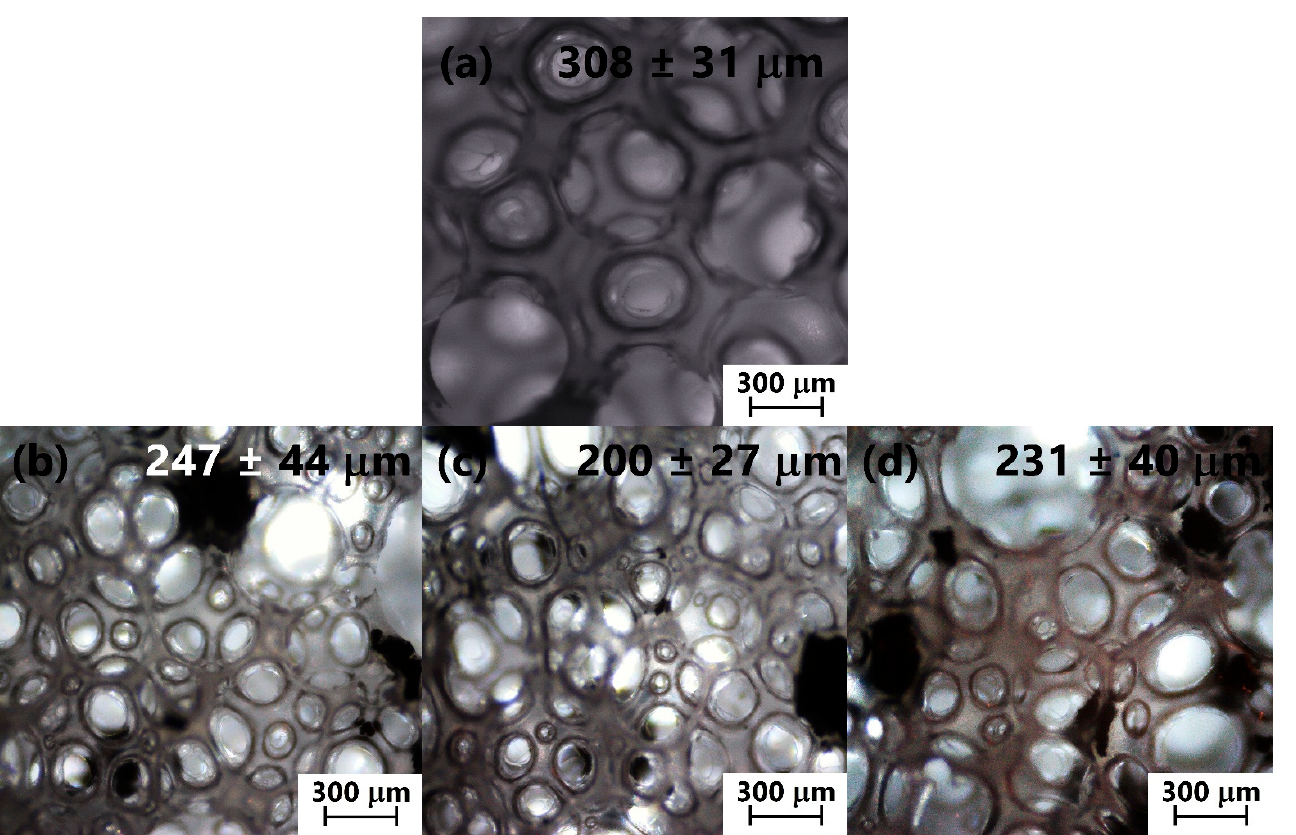
Figure 2. The impact of formulation on the temperature inside foam during polymerization.